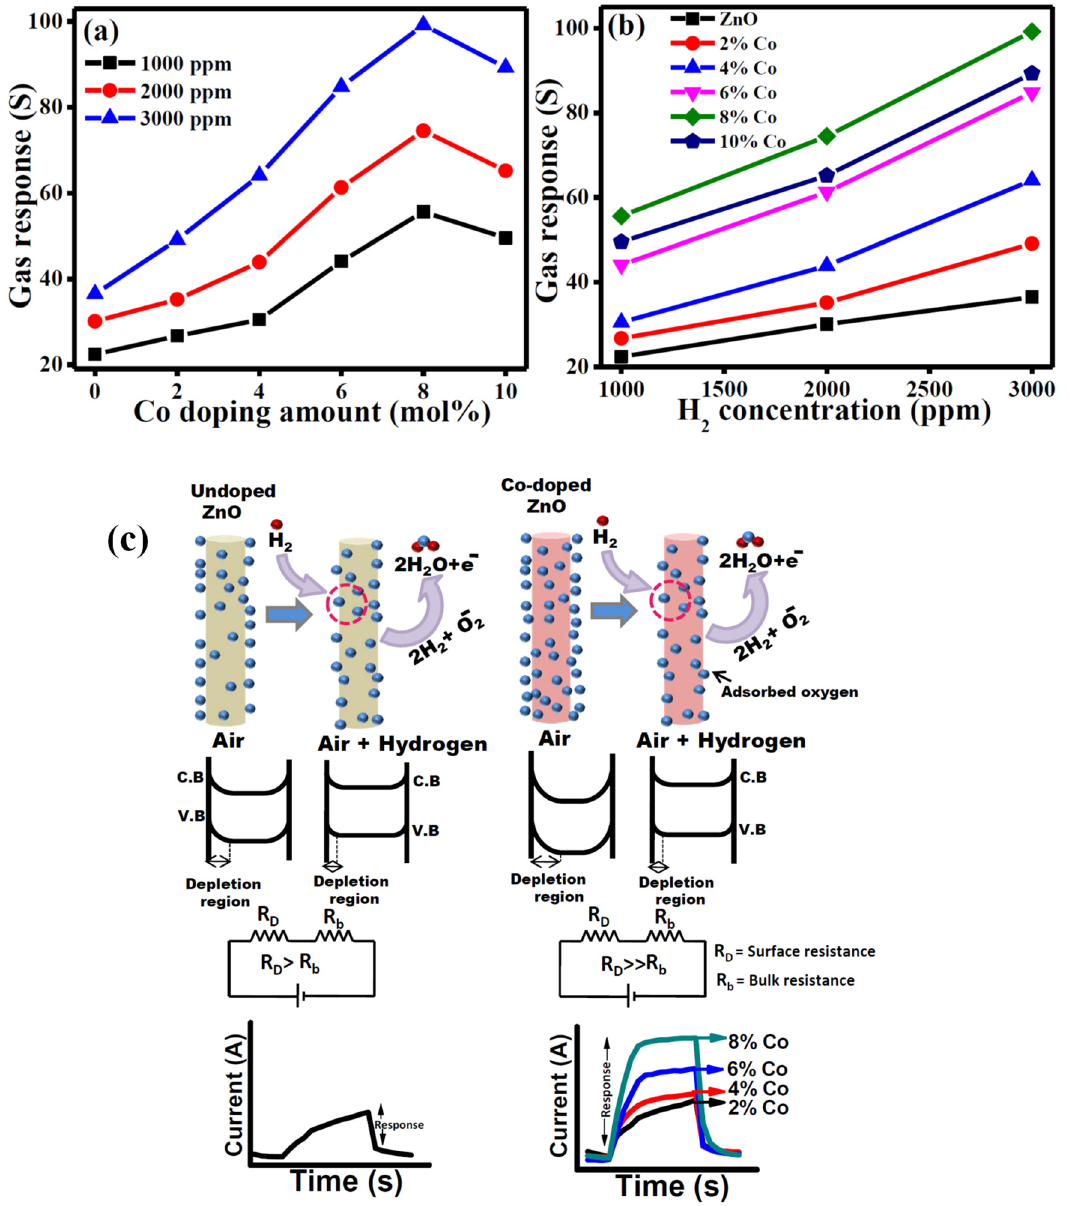
Figure 21: ( a ) Gas response with di ff erent Co - doping contents at 300°C, ( b ) gas response of all sensors for di ff erent H 2 concentration at 300°C, and ( c ) sensing mechanism of undoped and Co - doped ZnO NRs. Reproduced with permission from Elsevier [ 397 ]